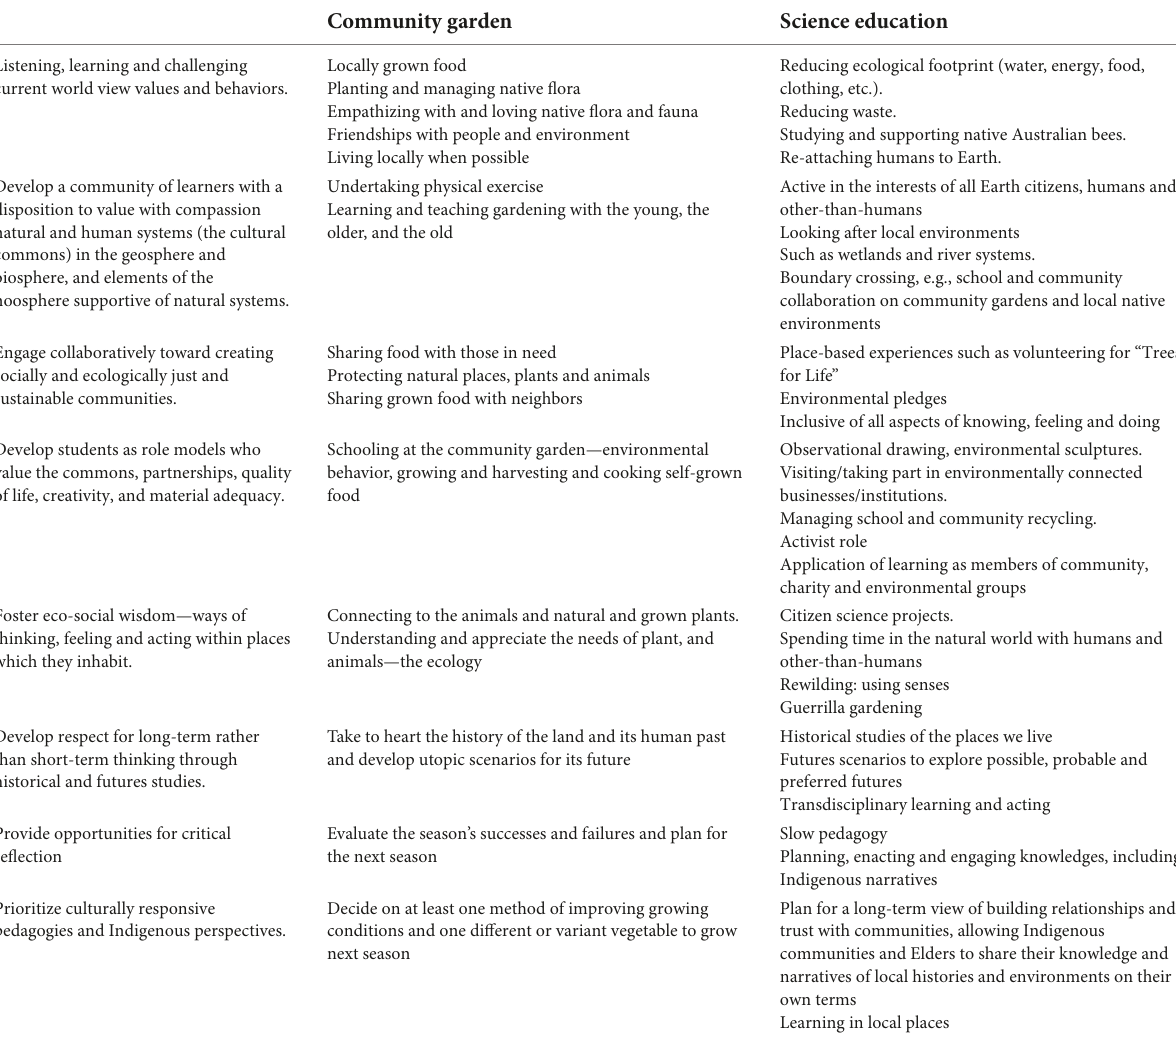
TABLE 2 Practical examples for community gardens and science education. Eco-justice